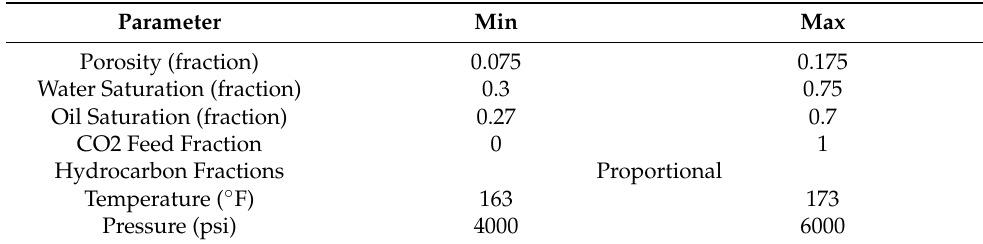
Table 3. Fluid EOS and rock physics study parameter ranges.